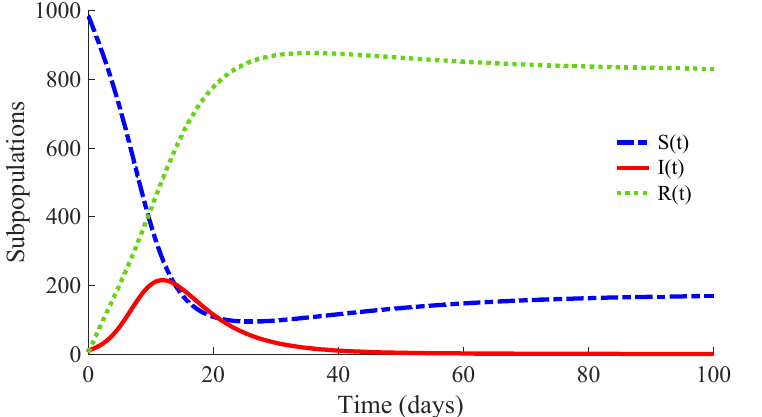
Figure 3. Time evolution of the subpopulations in the SIRS model with vaccination and treatment.